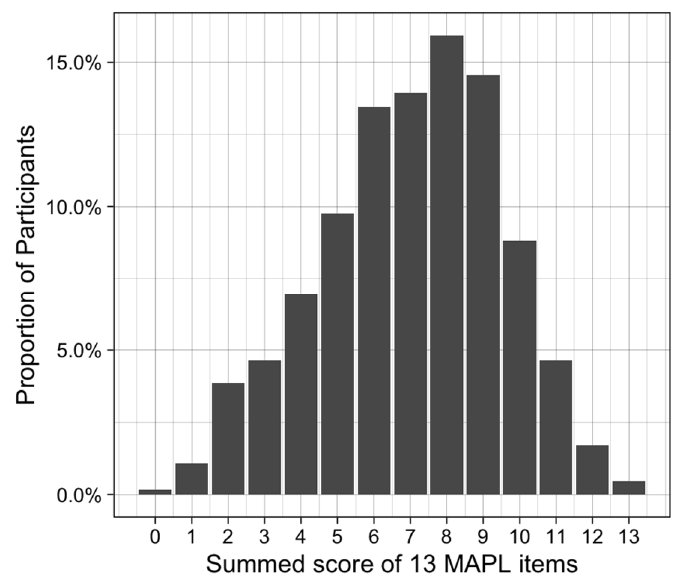
Figure 3. Summed score distribution for the 13-item MAPL.